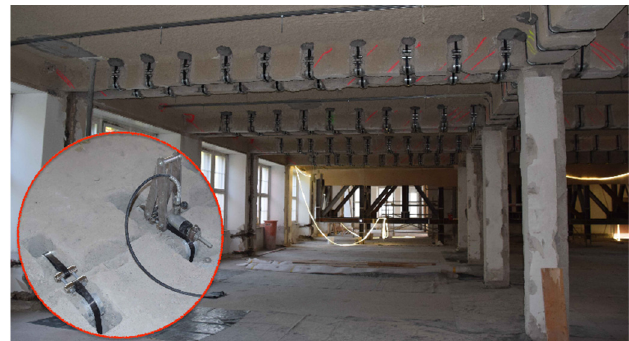
Figure 3. Slab reinforcement with prestressed non-laminated pin-loaded Straps (bottom left: prestress detail).